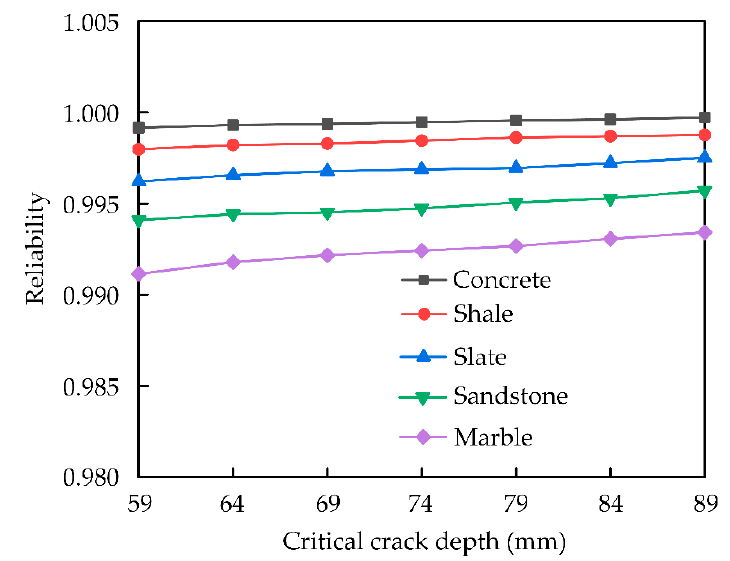
Figure 10. Relationship between the reliability of the cutterhead and the critical crack depth.